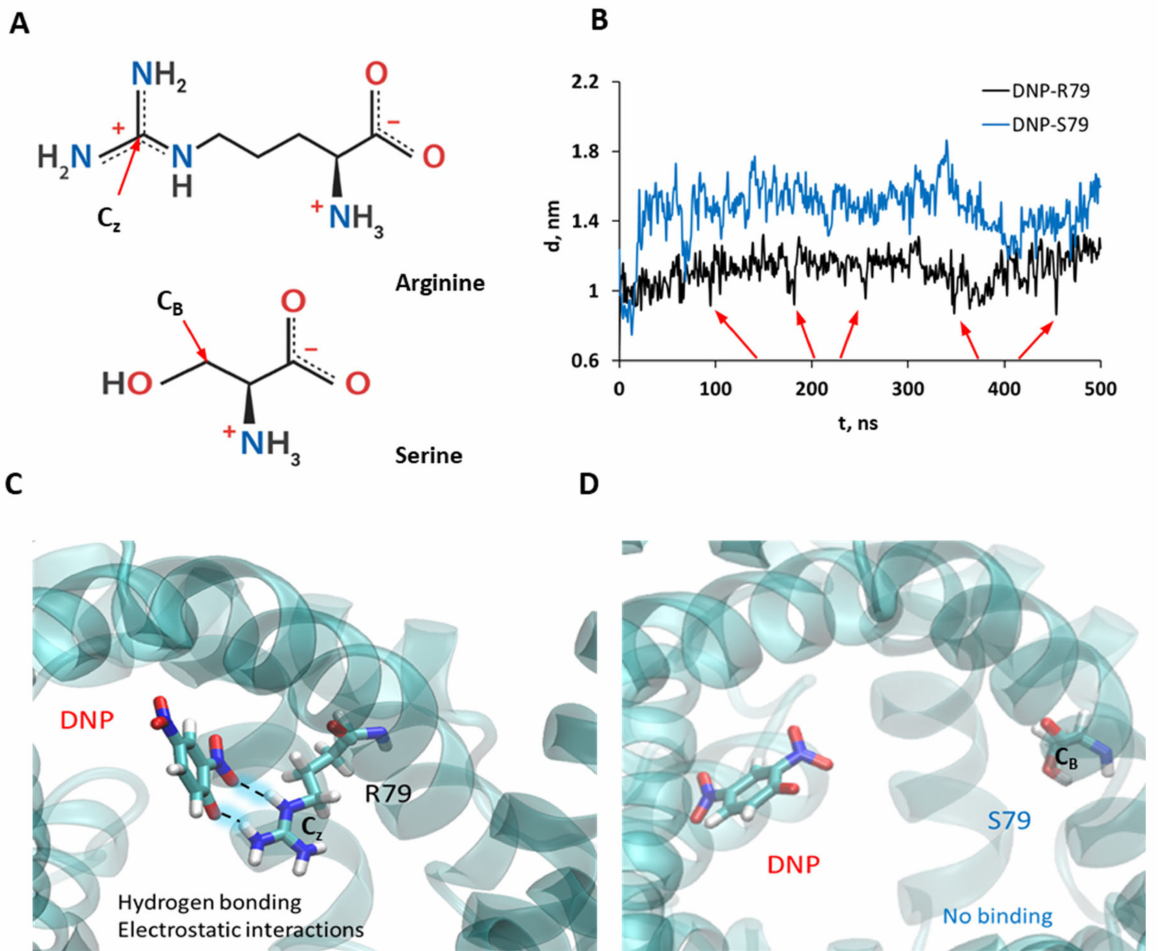
Figure 6. DNP binding in ANT1 and ANT1 R79S. ( A ) Structure of arginine and serine at pH = 7 in water. C Z is the central carbon atom of the guanidinium side chain in R79, and C B is the carbon atom in the side chain of S79. ( B ) Analysis of the distances between DNP’s center of mass and the C Z atom in R79 (black) and the C B atom in the S79 residue (blue). Red arrows indicate close contacts between DNP and R79. Selected snapshots from MD simulations of DNP in ANT1 ( C ) and DNP in ANT1 R79S ( D